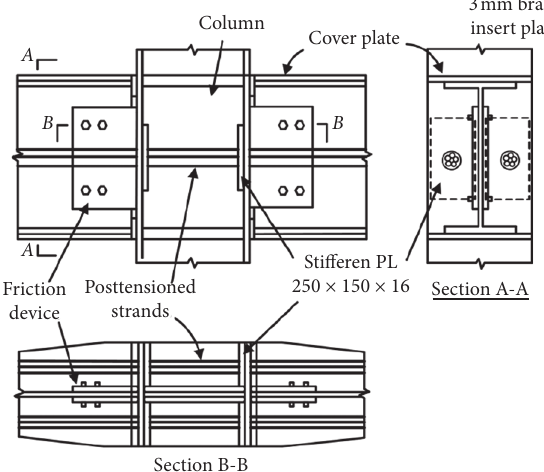
Figure 8: Schematic of posttensioned beam-to-column connection using friction devices (adapted from